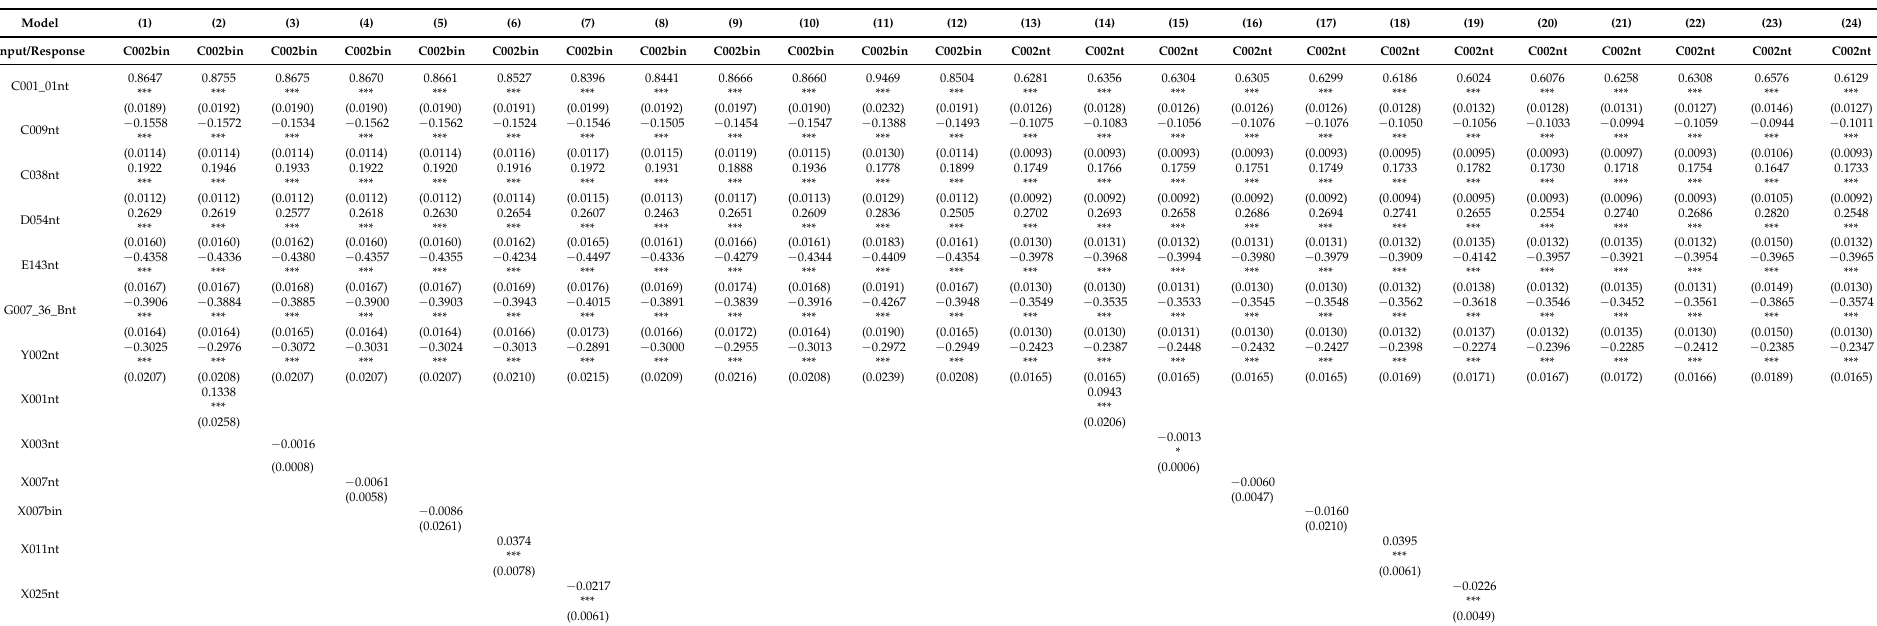
Table A6. Controlling using the most relevant seven remaining predictors (hepta-core) and most of the socio-demographic variables in logit (first 12) and ologit models (last